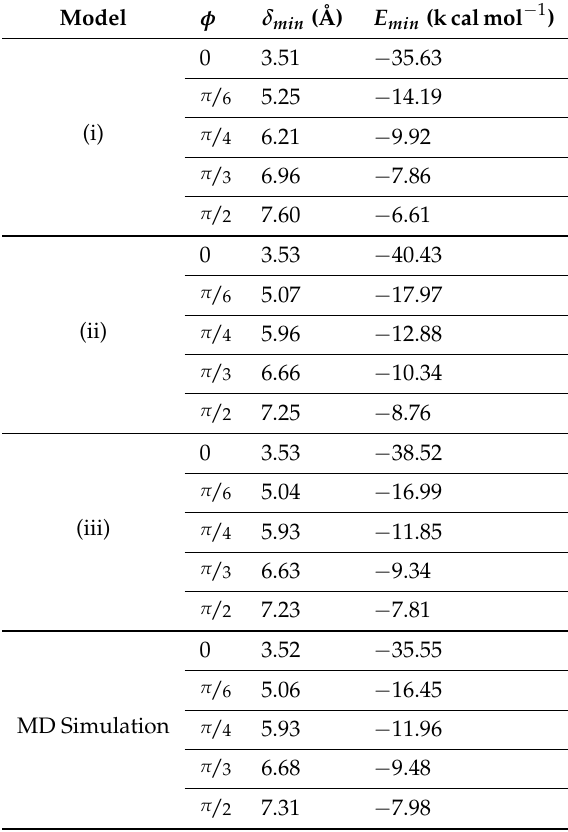
Table 3. Various minimum energies and corresponding displacements for the coronene–graphene interactions.